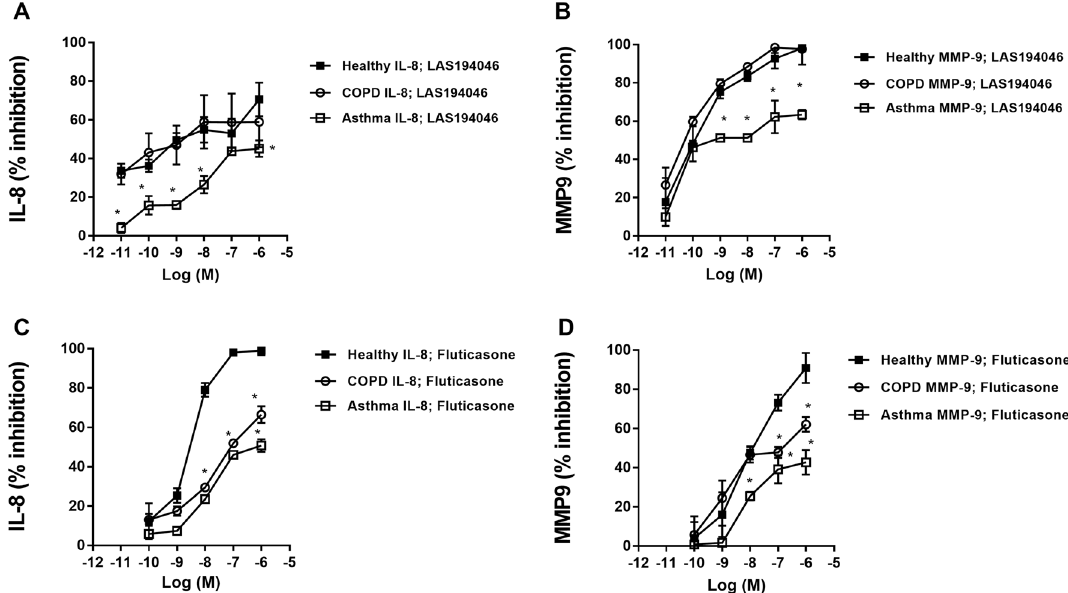
Figure 1. Effects of LAS194046 and fluticasone propionate on human neutrophil inflammation. Concentration- dependent inhibition of lipopolysaccharide (LPS)-induced IL-8 or MMP-9 release by ( A , B ) LAS194046 and ( C , D ) fluticasone propionate from peripheral blood neutrophils of healthy controls, severe asthma and COPD patients. Neutrophils were pre-incubated with LAS194046 or fluticasone propionate during 1 h followed by cell stimulation with LPS (1 µg/ml) for 6 h. The results are expressed as the mean ± SD (n = 3 each for cells from healthy controls, severe asthma and COPD patients in independent experiments with triplicate samples). A two- way ANOVA was followed by a post hoc Bonferroni test. *p < 0.05 vs. cells from healthy